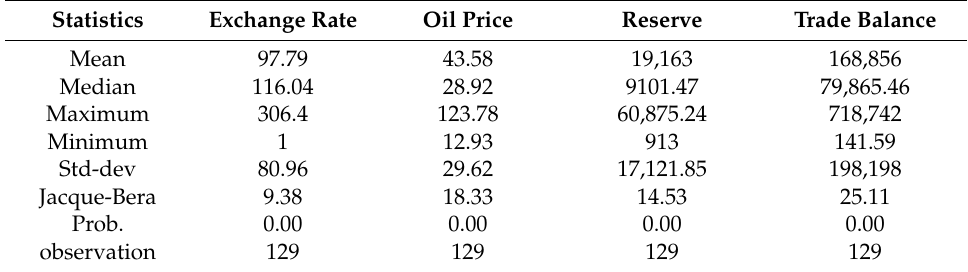
Table 4. Descriptive statistics.